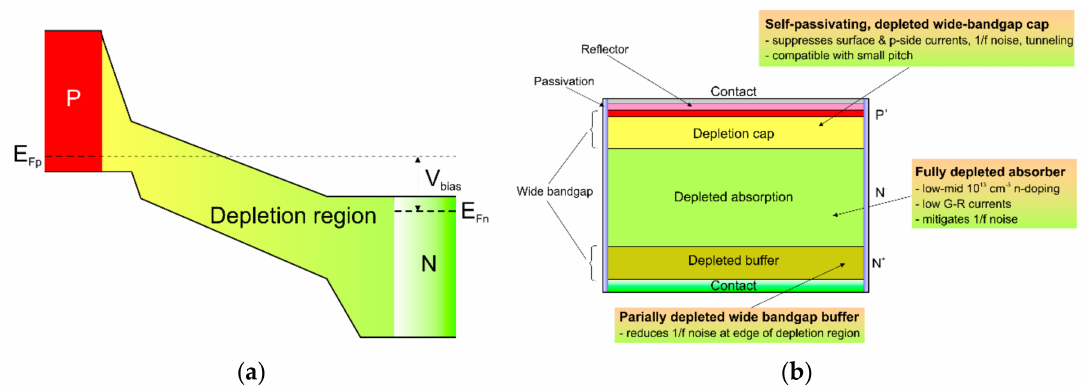
Figure 2. P-i-N detector: ( a ) energy band profile under reverse bias, ( b ) heterojunction architecture (adapted after refer- ence